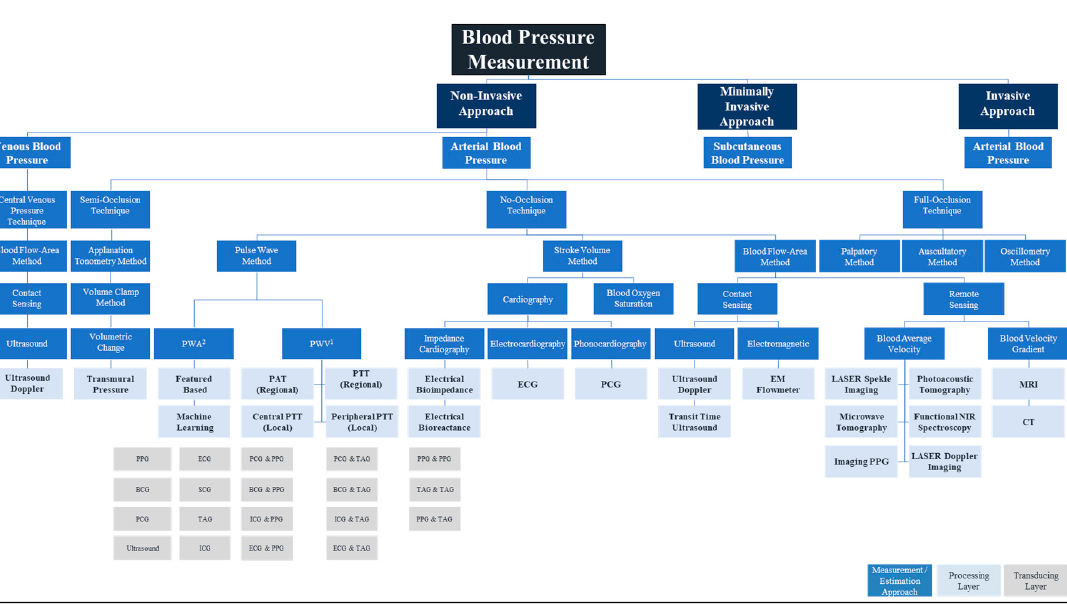
Figure 4. Blood pressure measurement landscape; approaches, methods, processing, and transducing layers. 1 PWA: At least a single pulsatility sensor or a single cardiovascular sensor is implemented; 2 PWV: At least two pulsatility sensors and/or additional cardiovascular sensor is